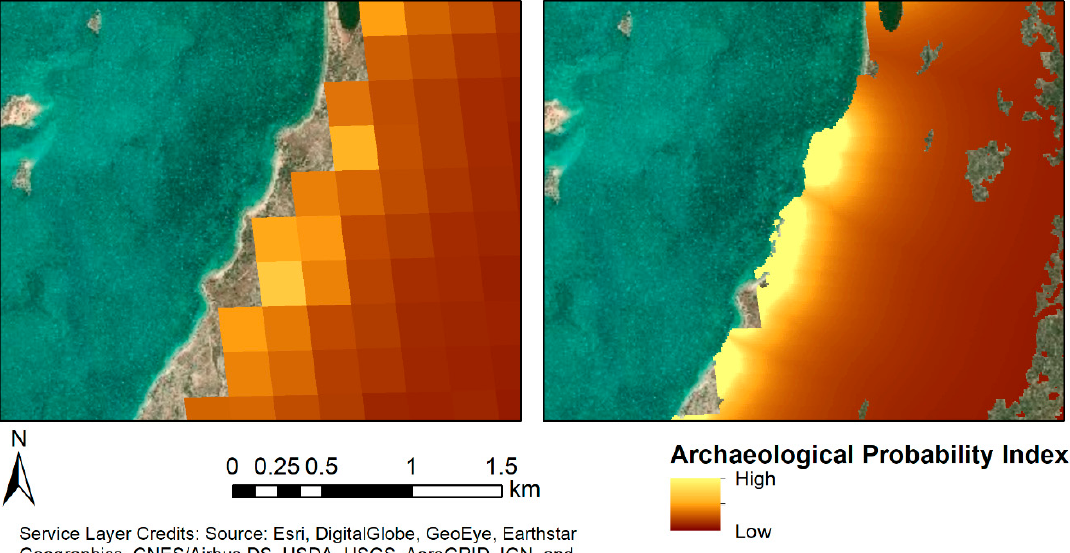
Figure 3. Left : shows the unweighted predictive raster without resampling depth to bedrock data from 150 m to 10 m. Right : shows the results of the unweighted predictive raster after resampling depth to bedrock data from 150 m to 10 m. Resampling makes the results more easily interpretable and by extension, usable for archaeological survey.